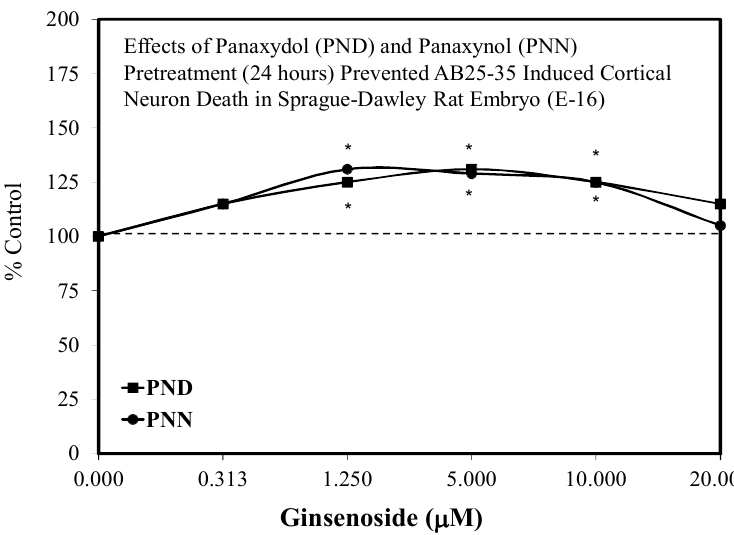
Figure 33. E ff ects of panaxydol (PND) and panaxynol (PNN) pretreatment (24 h) prevented AB25–35-induced cortical neuron death in Sprague–Dawley rat embryo (E-16) (source: [112]). Each * represent statistical significance for a data point.